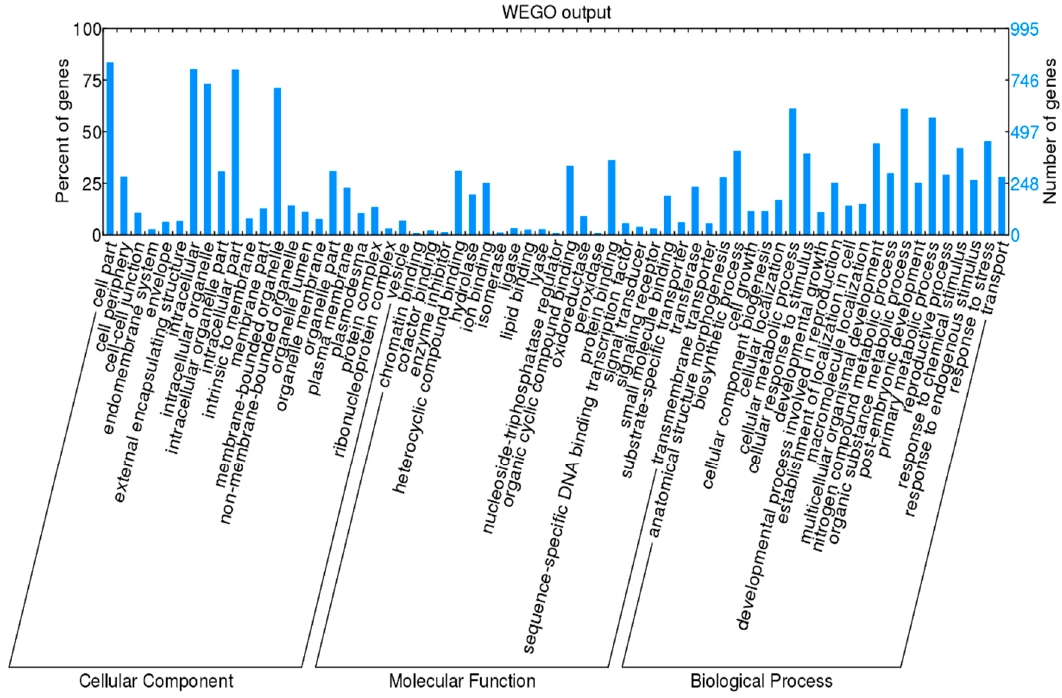
Figure 3. GO analysis for DEGs preferentially expressed in FL ovules. DEGs were grouped to the secondary classification of hierarchical GO terms.